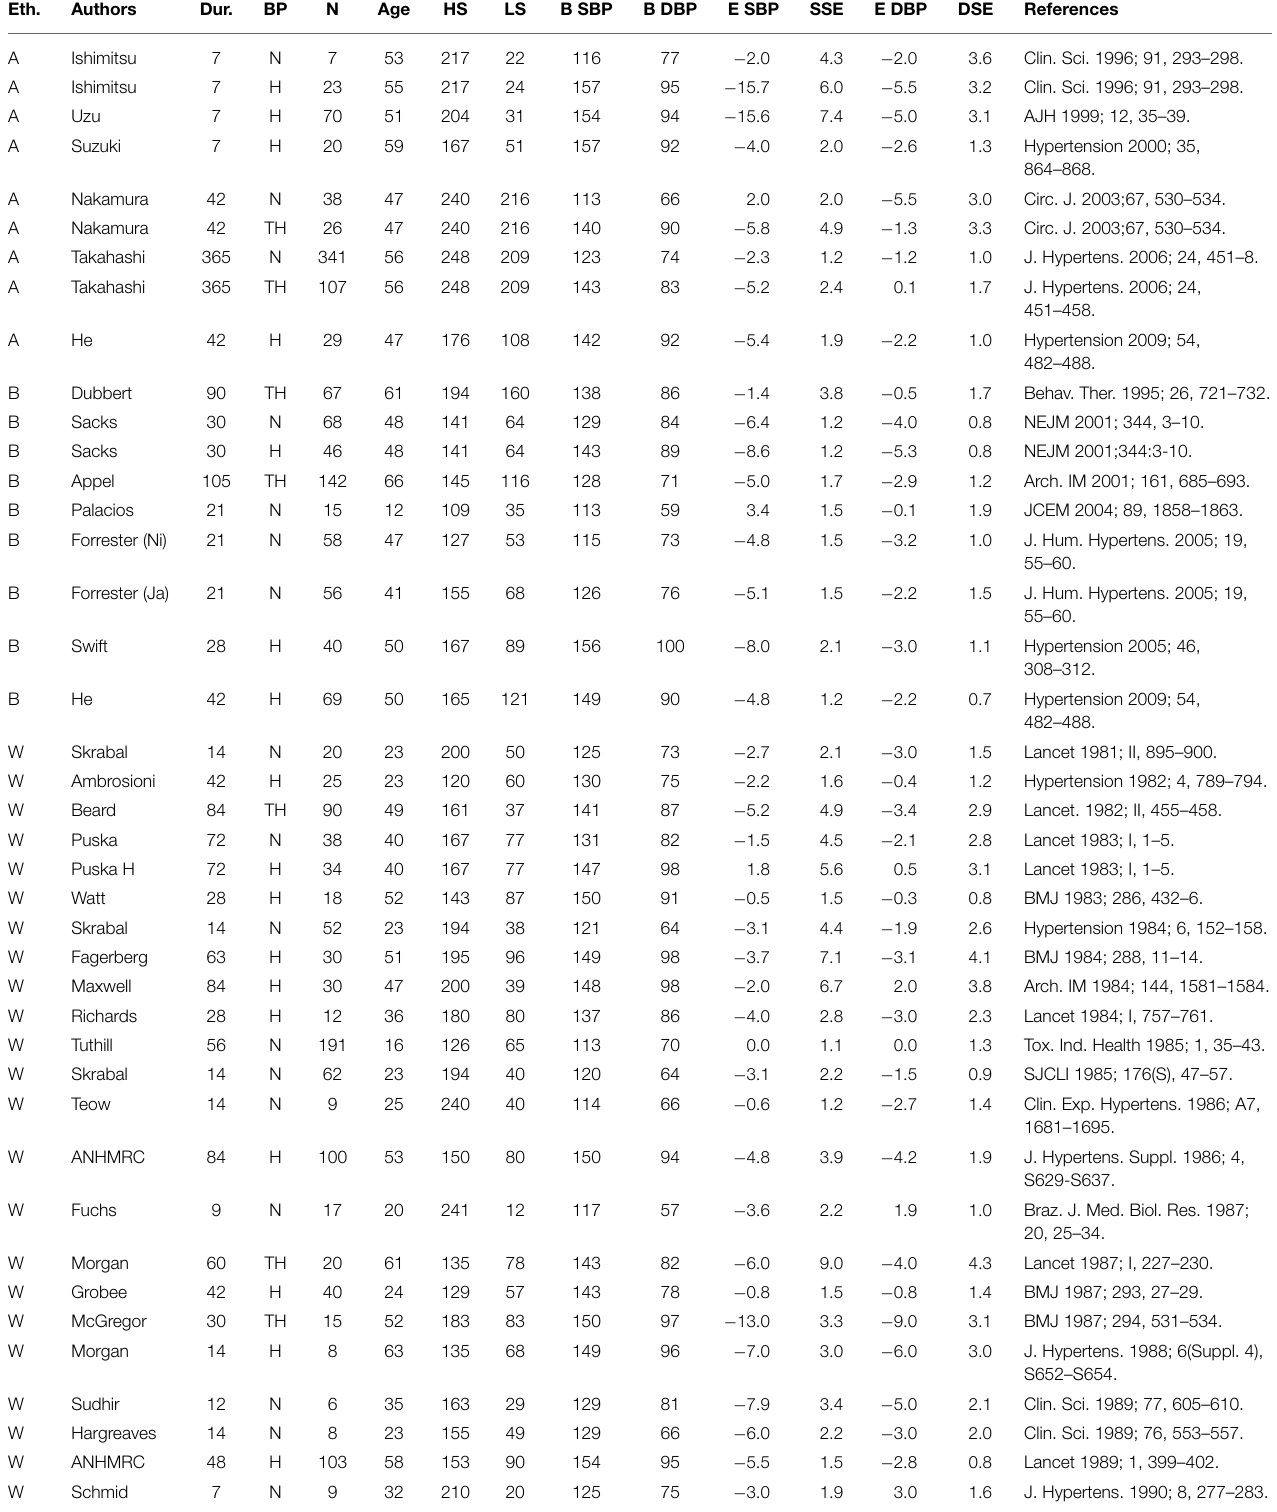
TABLE 1 | Baseline data, blood pressure outcome data and references of included studies.